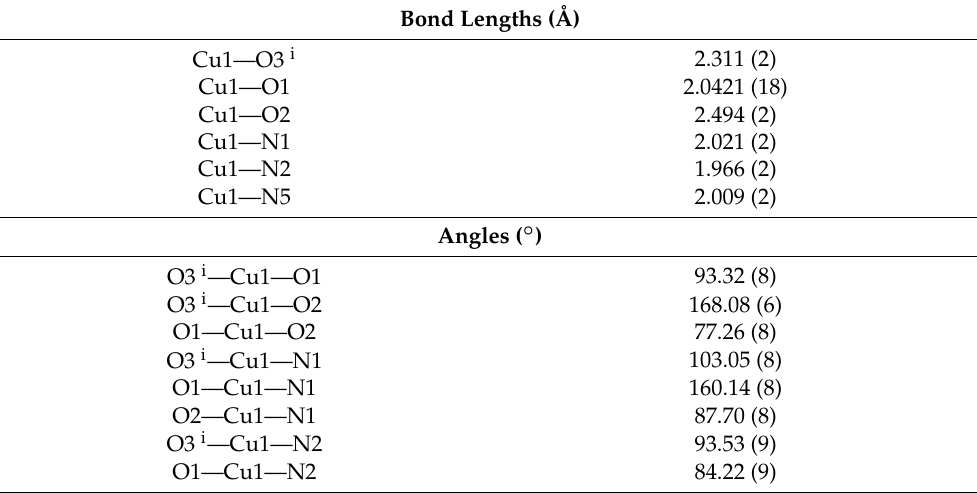
Table 2. Bond lengths [Å] and angles [deg] for [Cu(C 21 H 18 N 4 OS)(C 3 H 4 N 2 )(NO 3 )]n · n(NO 3 ) ( Cu-1